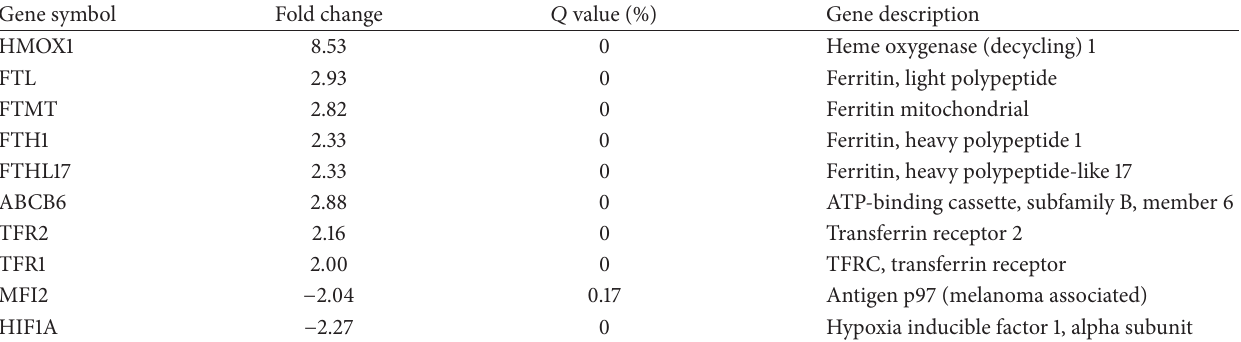
Table 2: List of genes with altered expression involved in iron ion